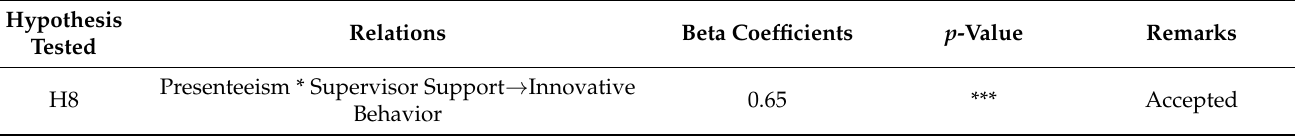
Table 8. Moderated behavior of supervisor support between health and innovative work